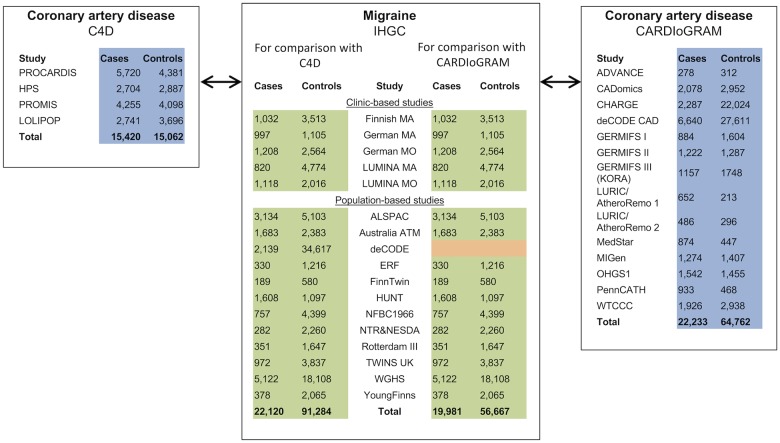
Overview of the included studies.